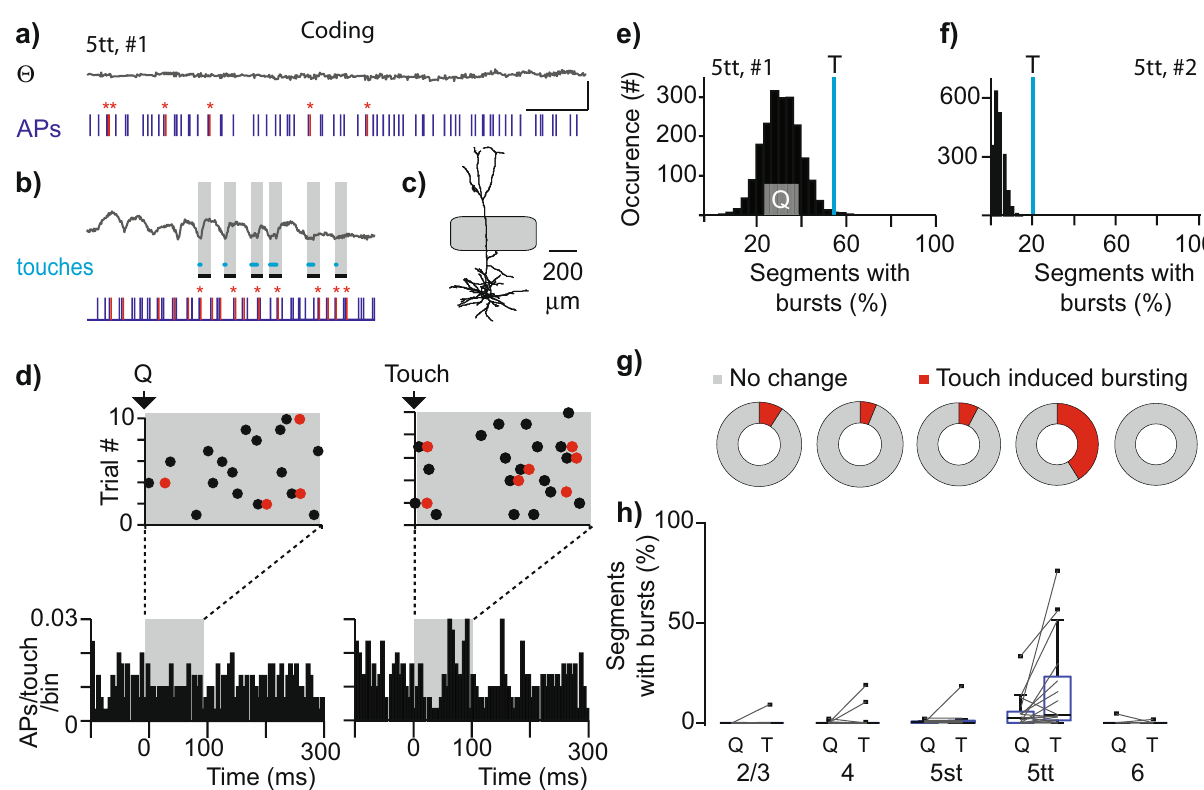
Fig. 5 Coding of touch using high-frequency AP bursts ( ≥ 100 Hz). a Loose-patch recording of a single L5tt illustrating high-frequency burst spiking during Quiescent episodes. Action potentials (APs) of instantaneous frequency ≥ 100 Hz are highlighted with red asterisks. Θ denotes whisker position. Scale bar: 25 degrees, 500 ms. b Analogous to (a) but for episode with consecutive touches. Gray shaded boxes indicate 100 ms after touch onset. c Digital reconstruction reveals L5tt morphology. d Raster plots and PSTHs triggered to random quiescent and true touch times. APs at instantaneous frequency of ≥ 100 Hz are indicated by red bullets. e Histogram of the bootstrapped burst distribution based on 100 ms Quiescent segments and the recorded fraction of touches (0 – 100 ms touch start window) with high-frequency bursts as a blue line. Note that fraction of touches with bursts exceed 99th percentile of distribution, equivalent of p < 0.01. f Bootstrapped burst distribution for 2nd L5tt example, p < 0.01. g Seven out of 17 L5tt pyramids show an increase of bursting upon touch, which is a signi fi cantly higher fraction compared with additional excitatory cell types (3/50), p < 0.01, two-sided Chi-square test). h Fraction of segments with a burst in Q(uiescent) and T(touch) windows as a function of cell-type (touch: Kruskal – Wallis, p < 0.0001, post hoc L5tt vs L2/3 or L4 or L6, all p < 0.001). Boxplots show median as central mark, the edges of the box the 25th and 75th percentiles, the whiskers extend to the most extreme data points, and the outliers are plotted